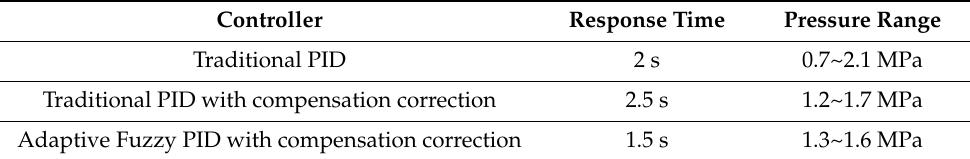
Table 4. Control e ff ect of di ff erent